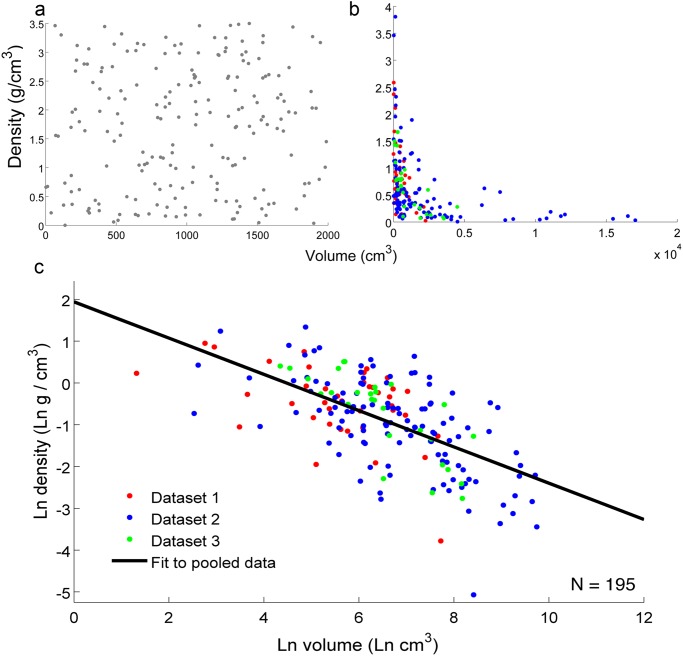
Environmental data.‘Uniform distribution’ predictions (a) differ markedly from the observed power function relationship between volume and density (b). For ease of viewing, (c) displays the natural log-transformed scatterplot of the power function relationship between volume and density for man-made objects, showing a significant inverse correlation between log volume and log density.